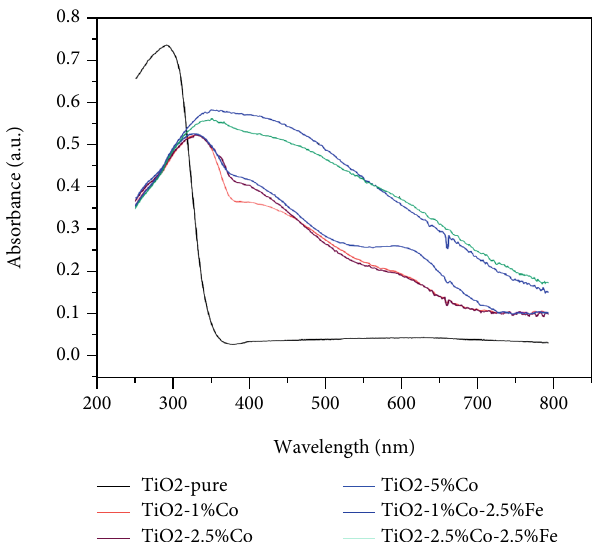
Figure 6: UV-vis spectra of undoped TiO 2.5%Co, TiO 2.5%Fe